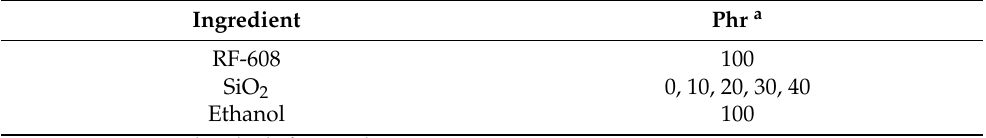
Table 1. SiO 2 /waterborne polyurethane hydrophobic coating formula. Ingredient Phr a RF-608 100 SiO 2 Ethanol